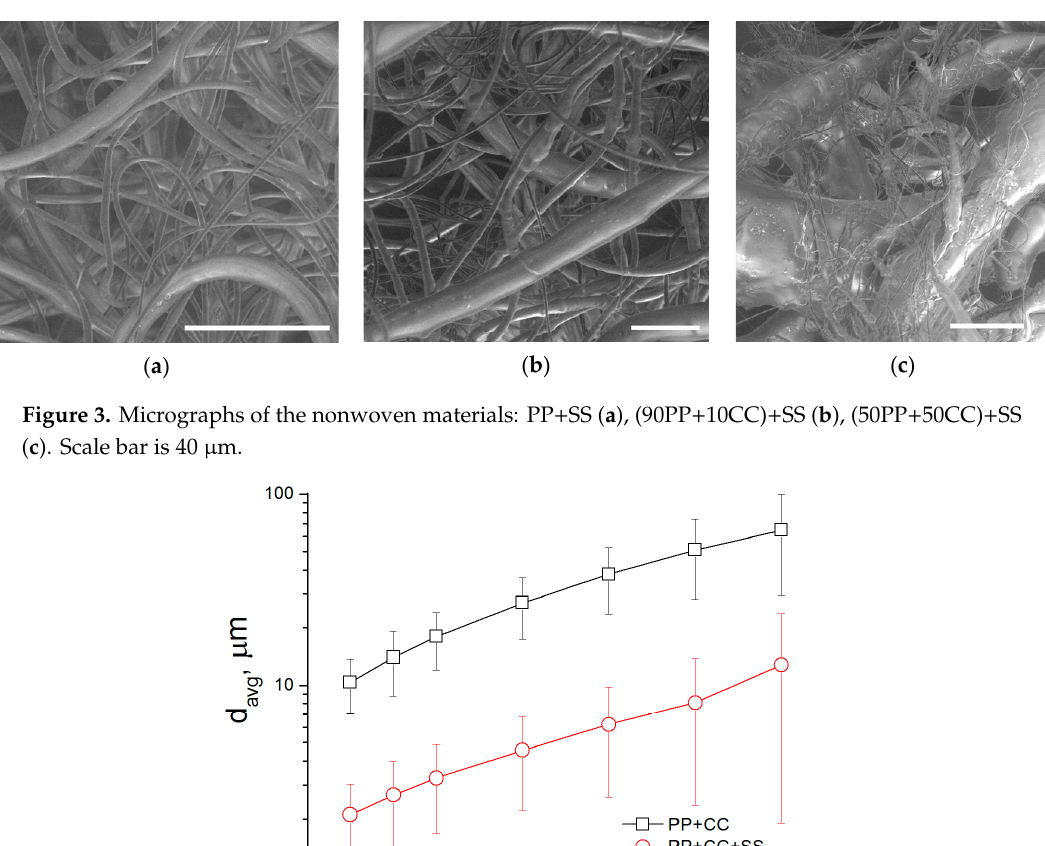
Figure 3. Micrographs of the nonwoven materials: PP+SS ( a ), (90PP+10CC)+SS ( b ), (50PP+50CC)+SS ( c ). Scale bar is 40 μ m.